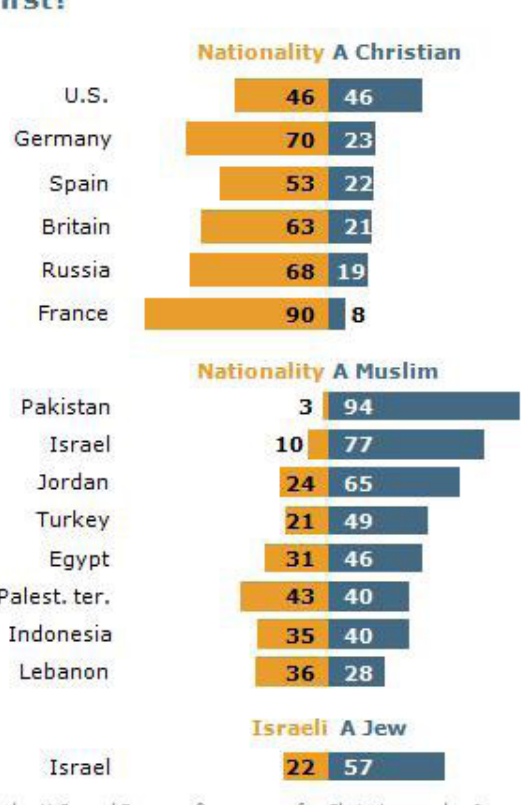
Figure 2: In the US & Europe the figures are for Christians only while in remaining countries they are for Muslims